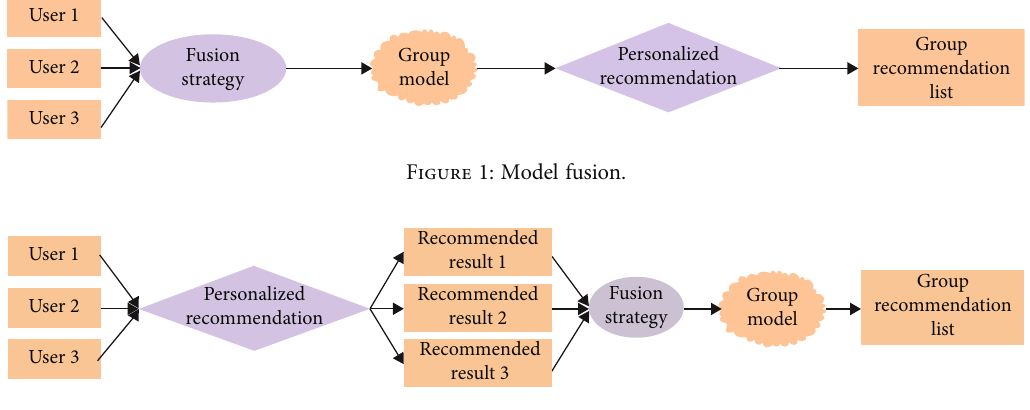
Figure 2: Recommendation